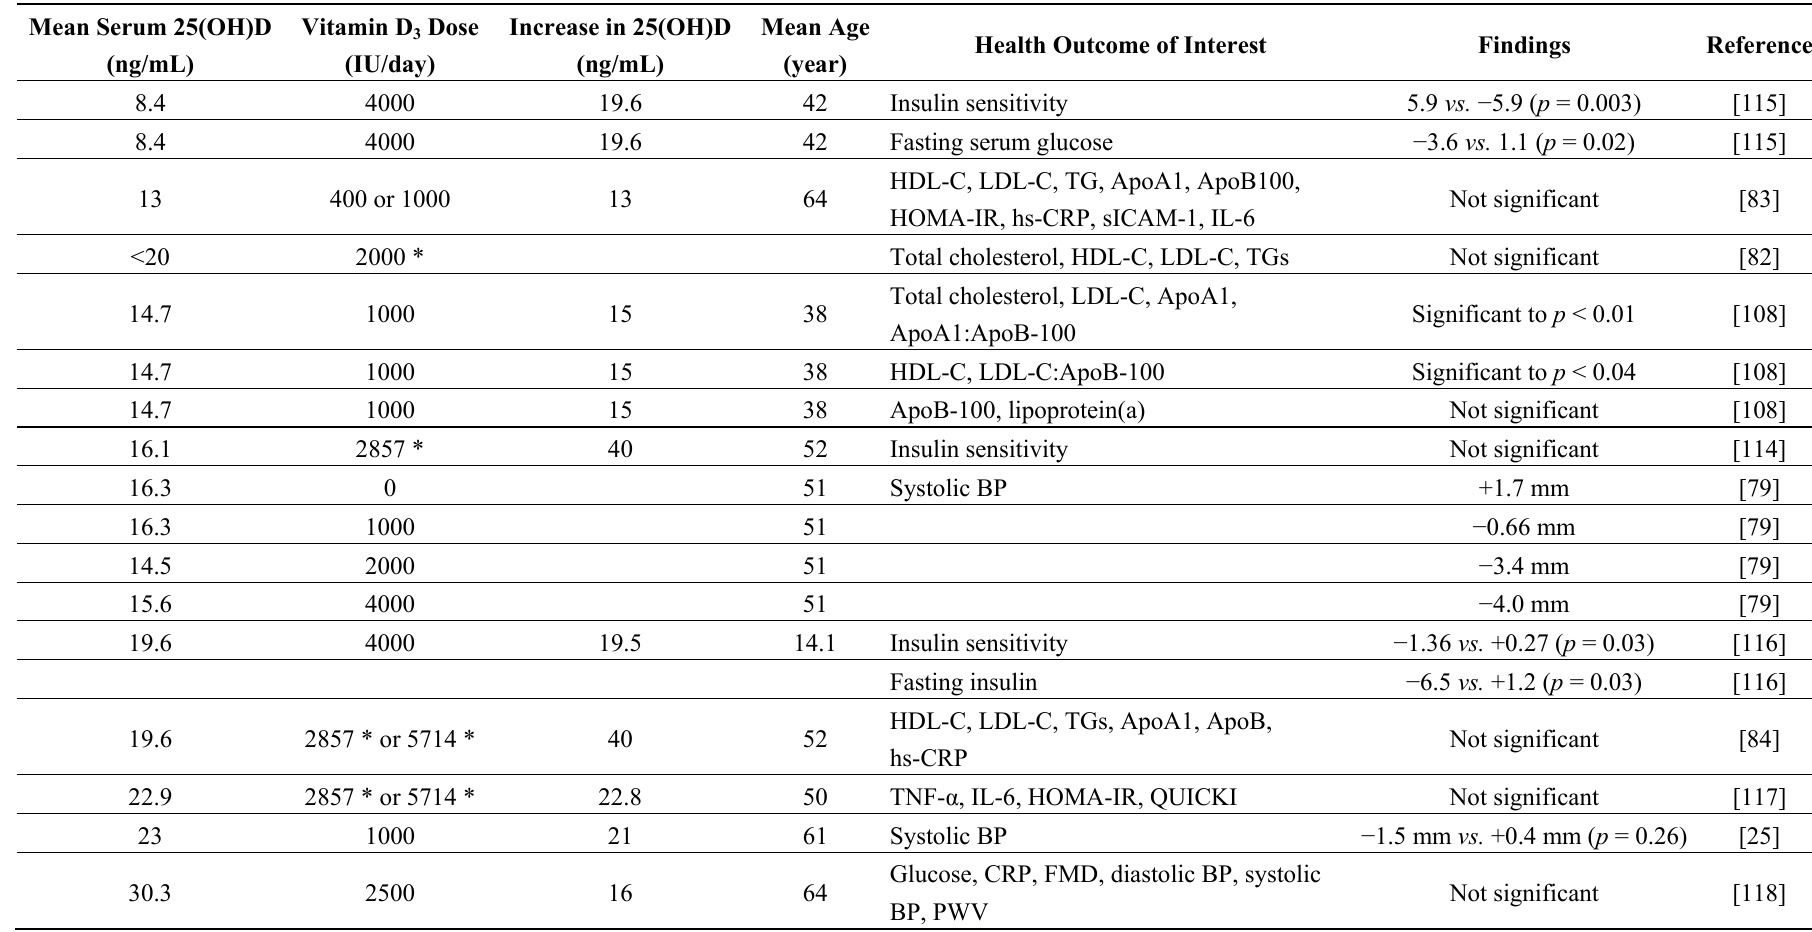
Table 3. Results of studies on vitamin D supplementation and CVD risk factors (ordered by mean serum 25(OH)D (ng/mL)). Mean Serum